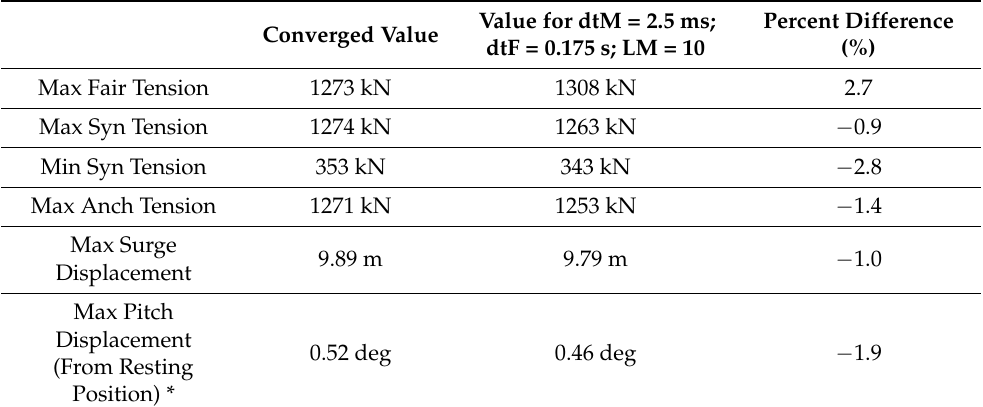
Table 9. OpenFAST and MoorDyn Convergence